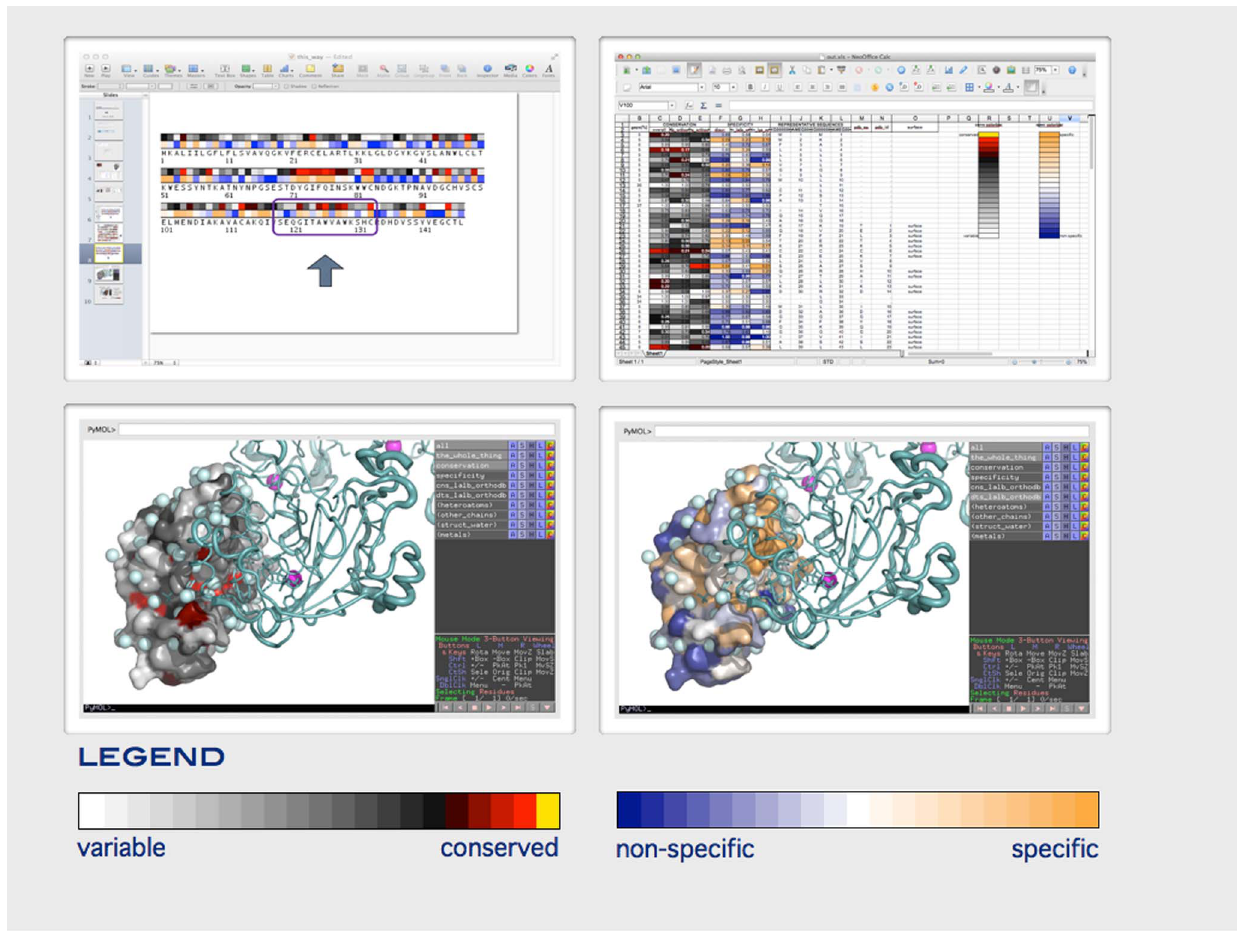
Figure 1. Visualization in Cube. Clockwise from top left: one dimensional map in png format, spreadsheet tabulation of conservation, specialization and annotation provided by the user, specialization mapped on the structure, and conservation mapped on the structure. The example shown: specialization between lysozyme C and a -lactalbumin. (See http://eopsf.org/cube/help/worked_examples/spec_examples.html.).